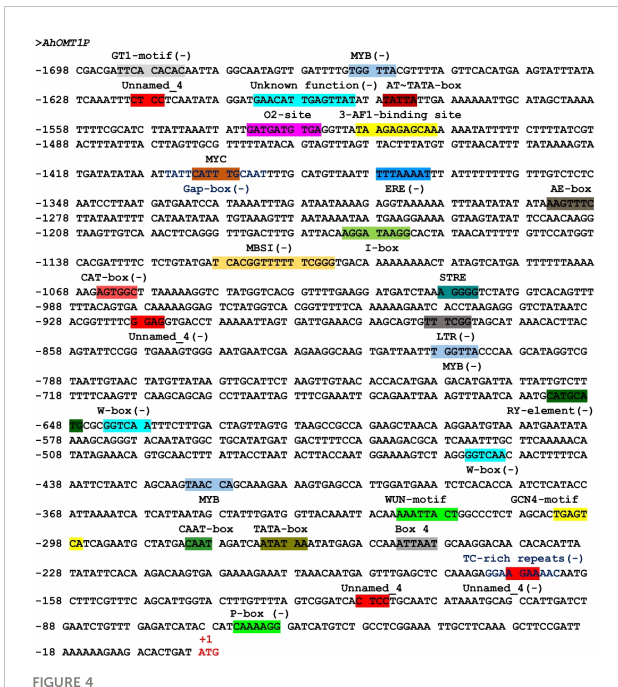
FIGURE 4 Sequence analysis of AhOMT1 promoter. Presence of cis -elements in promoter sequences predicted by the PlantCARE